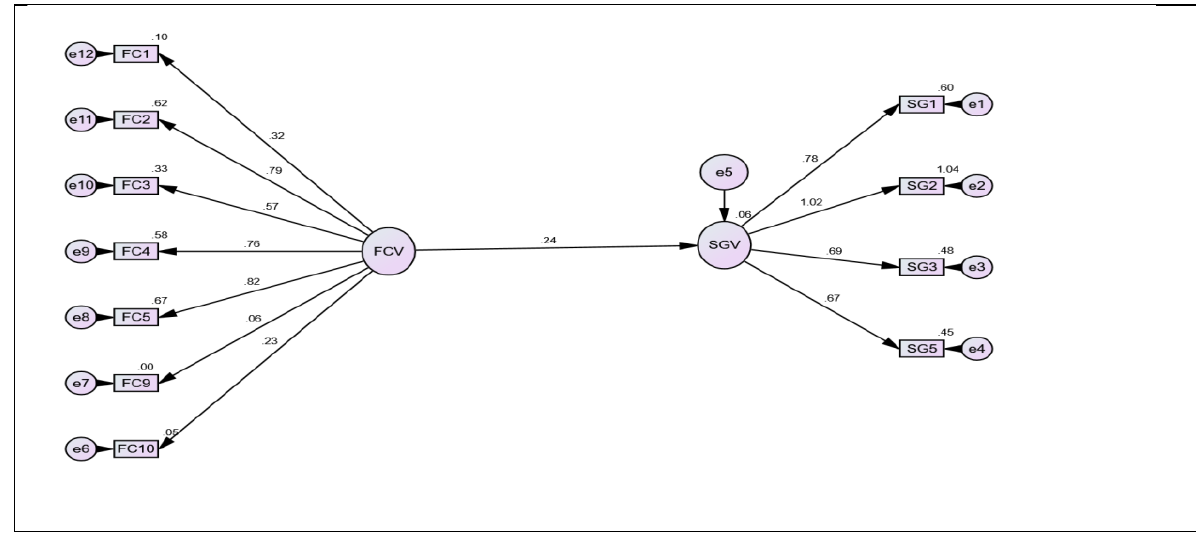
Figure 1: The weights of the structure model in the relationship between Financial control and growth